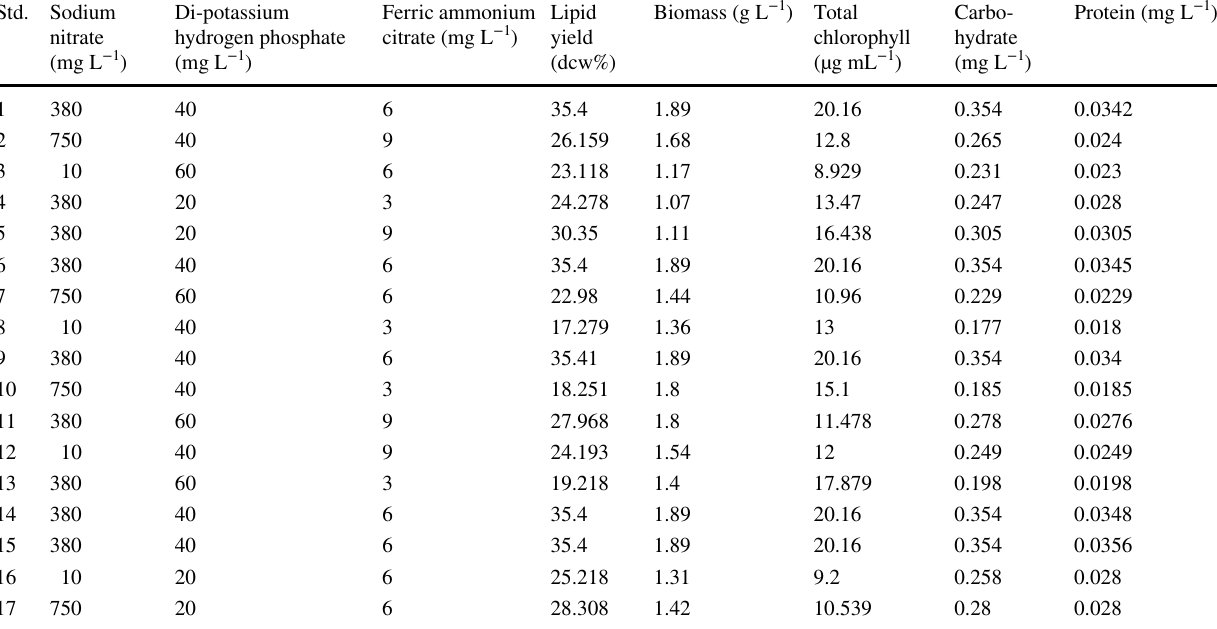
All the experiments were run at central